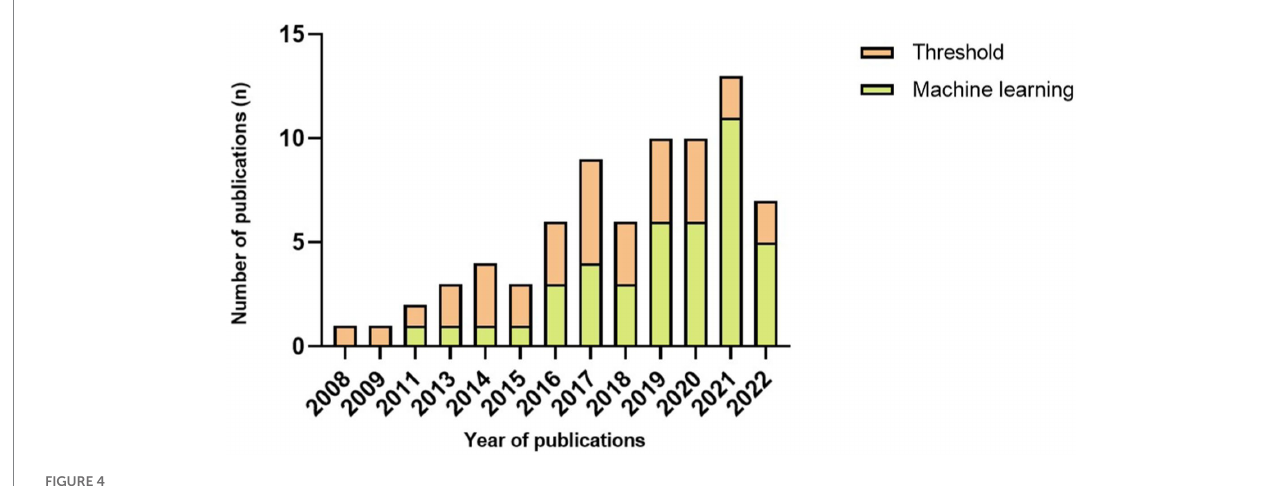
FIGURE 4 Number of publications each year per type of algorithm.